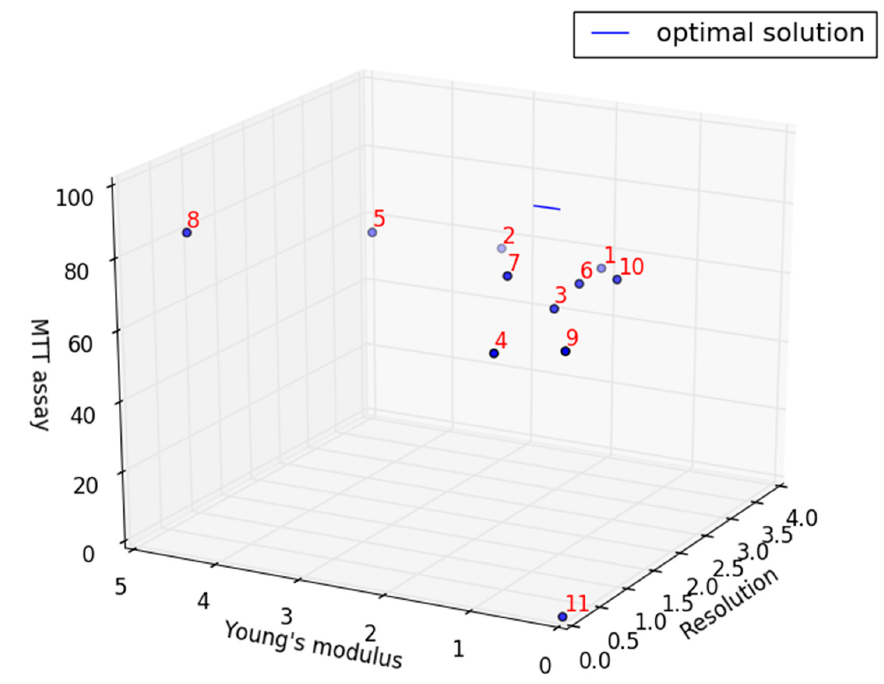
Figure 6. Three-dimensional scatter plot of resolution, Young’s modulus and cell viability. Table 3. The distance between the response variables and the coordinate values of the expected values.